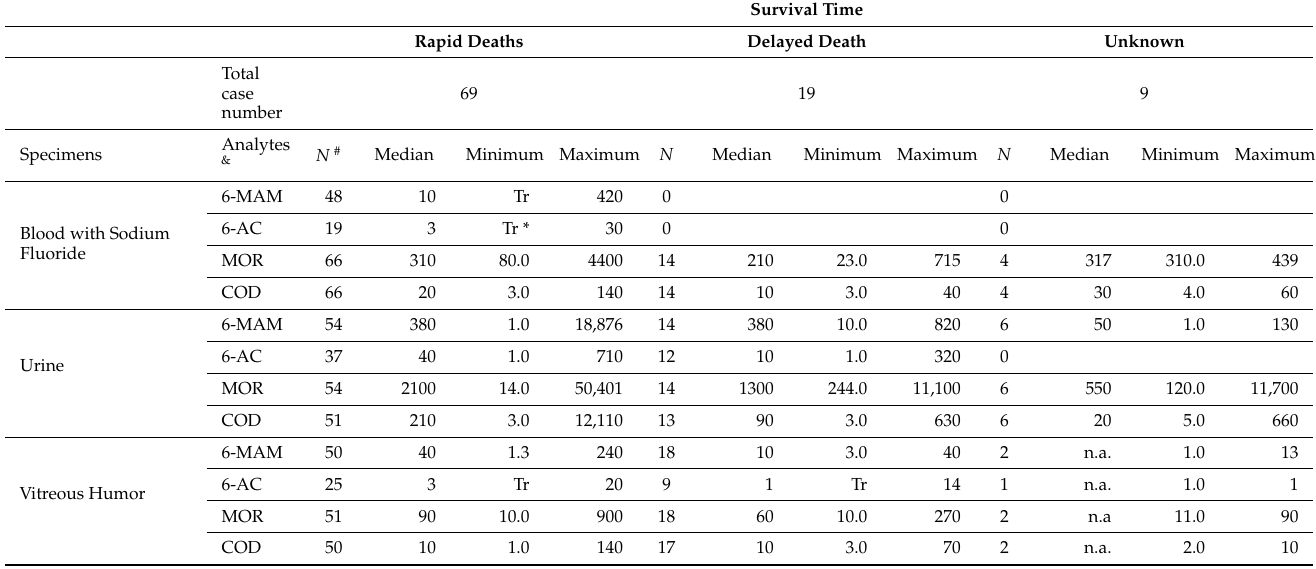
Table 3. Heroin biomarkers, morphine, and codeine concentration in relation to survival time following heroin administered in the current